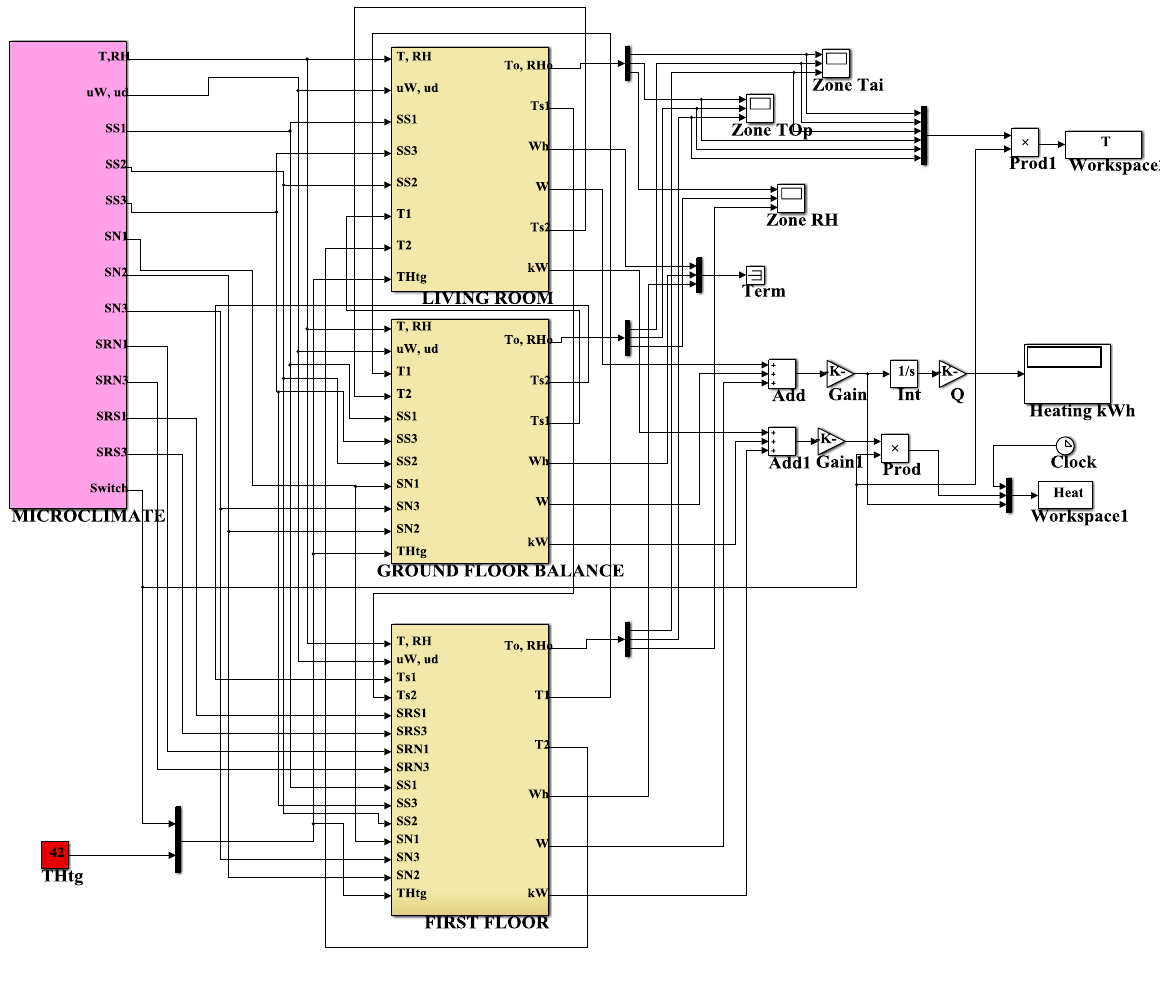
Figure B2. Top-level block diagram model for the mid-terrace house.